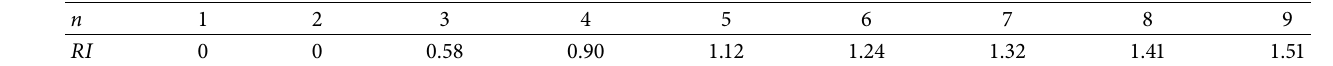
Table 2: Values of random consistency index RI.